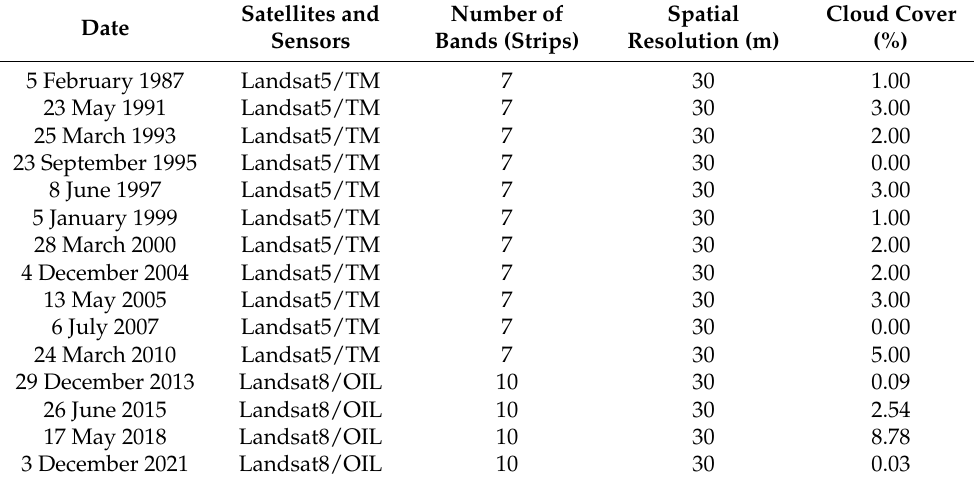
Table 1. Parameters of satellite